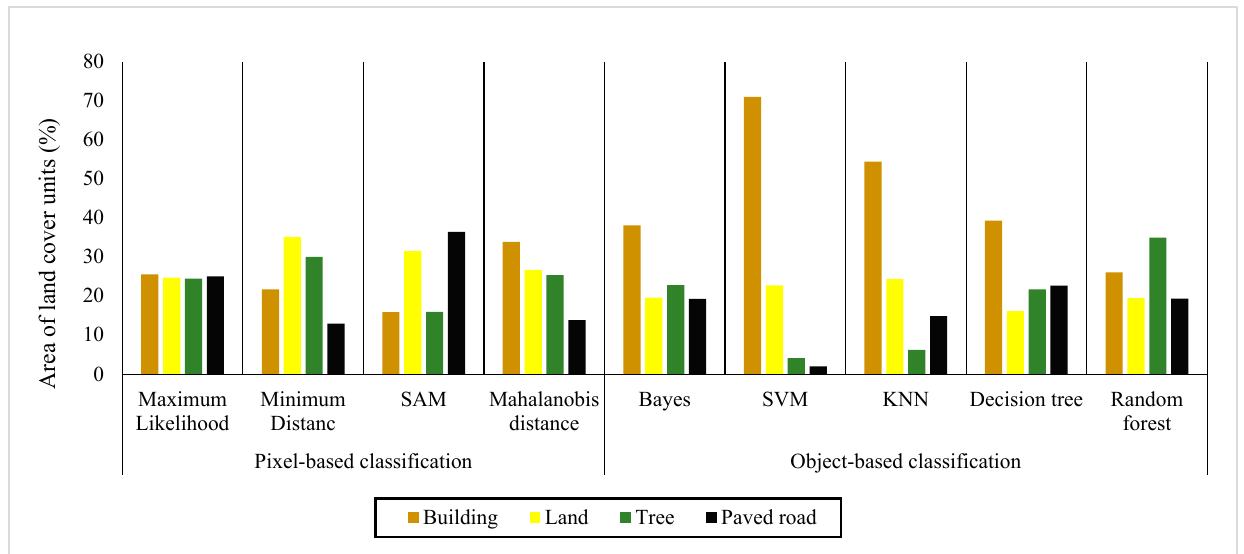
Figure 6. Percentage area of different land cover units (buildings, barren land, trees, roads) identified when using pixel-based and object-based methods to classify Google Earth images.